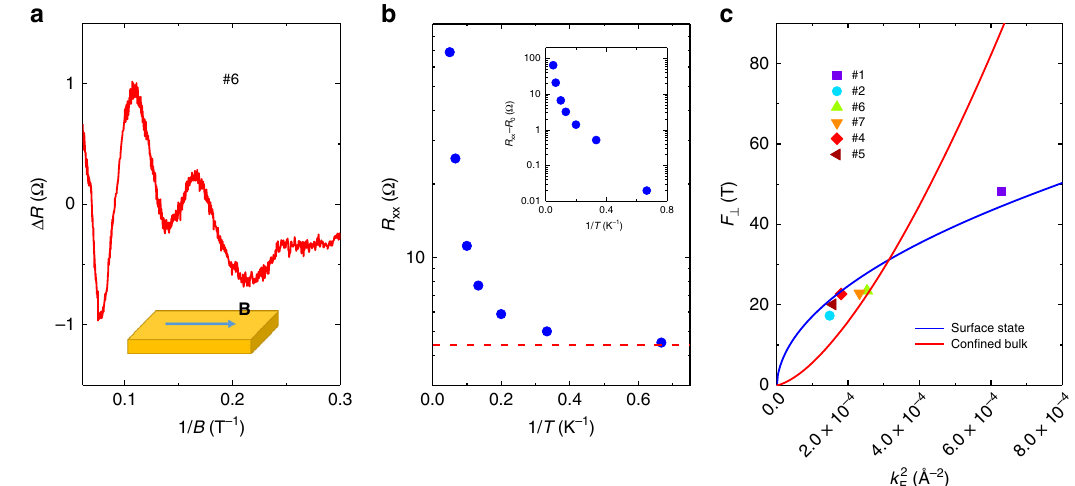
Fig. 5 Energy dependence of SdH oscillation frequency. a The extracted SdH oscillations with in-plane magnetic fi eld in sample #6, indicating the existence of 3D bulk states. b The resistance minima of ν ¼ 10 in sample #6 at different temperatures. It gradually deviates from the thermal activation behavior and becomes saturated toward zero temperature. The inset of b is the resistance minimum value with the residue subtracted. c The relation of the oscillation frequency F ? with out-of-plane magnetic fi eld ( θ = 0°) and the square of bulk Fermi wave vector k 2 . The blue and red curves describe two predicted F relations between k 2 and F ? based on the surface-state and con fi ned-bulk-state scenarios, F